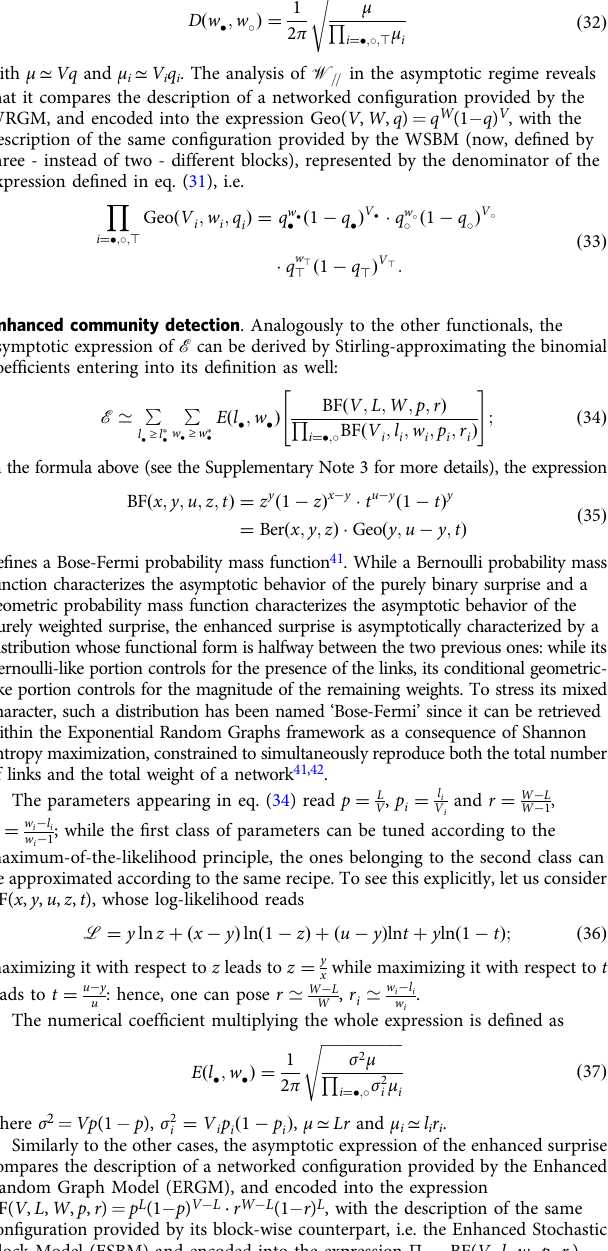
ffiffiffiffiffiffiffiffiffiffiffiffiffiffiffiffiffiffiffiffi